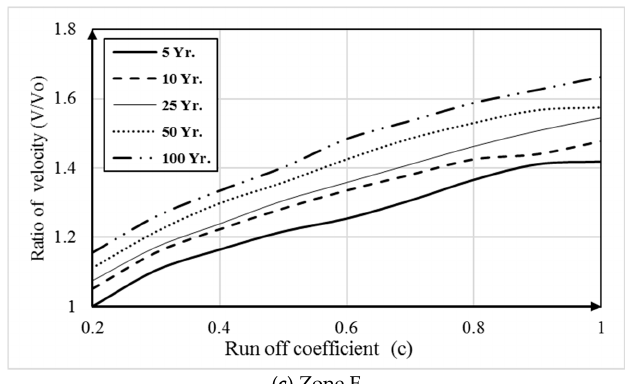
Figure 10. Relationship between runoff coefficient (C) and average velocity for zones A ( a ), C ( b ) and E ( c ).